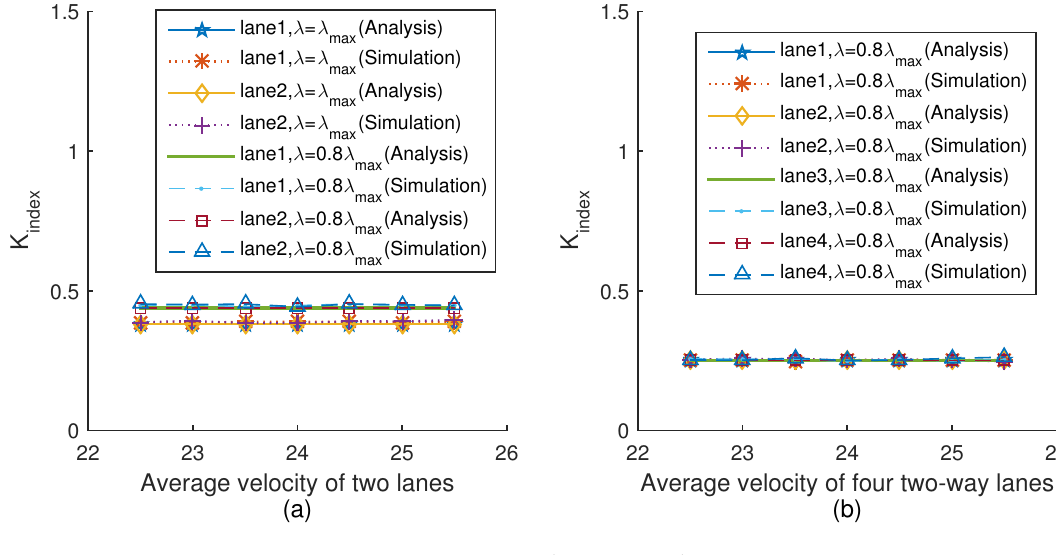
Figure 4. Fairness index versus velocity.